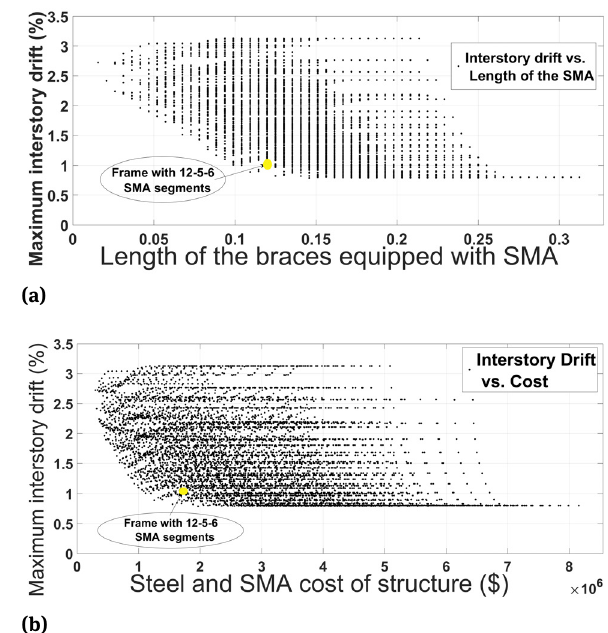
Figure 6: Maximum interstory drift of the produced frames; (a). Length of the SMA segments; (b). Steel and SMA construction